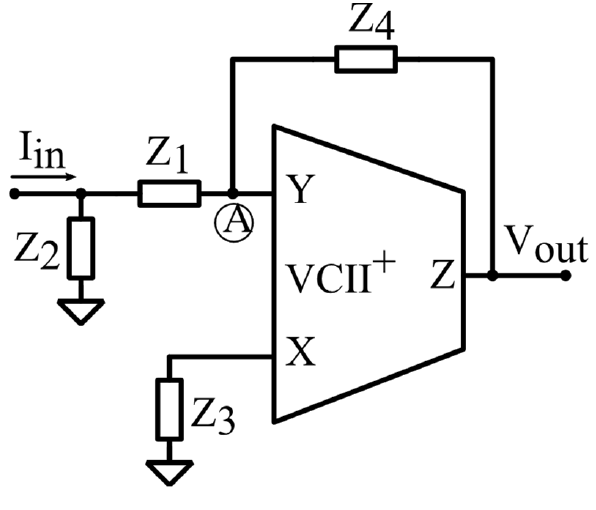
Figure 10. VCII-based reconfigurable low-pass band-pass filter for ultrasonic PVDF sensors [25].